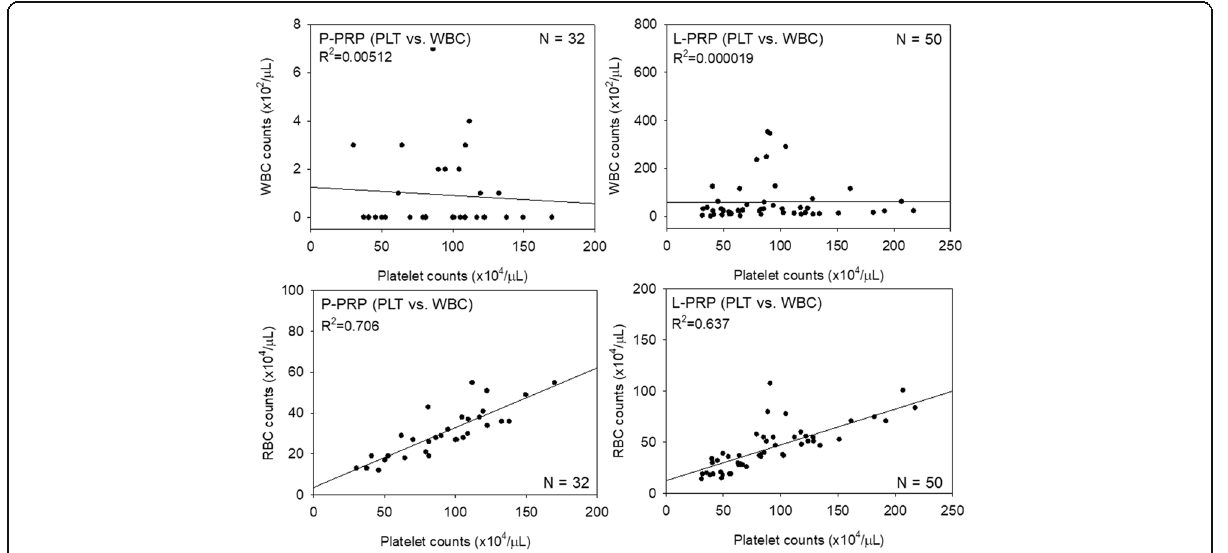
Fig. 6 Scatter plots representing possible correlations between platelet (PLT) and WBC counts and between platelet and RBC counts in P-PRP and L-PRP preparations. Note: strong positive correlations were observed between platelets and RBC in both PRP types. N = 32 and 50 for P-PRP and L-PRP,